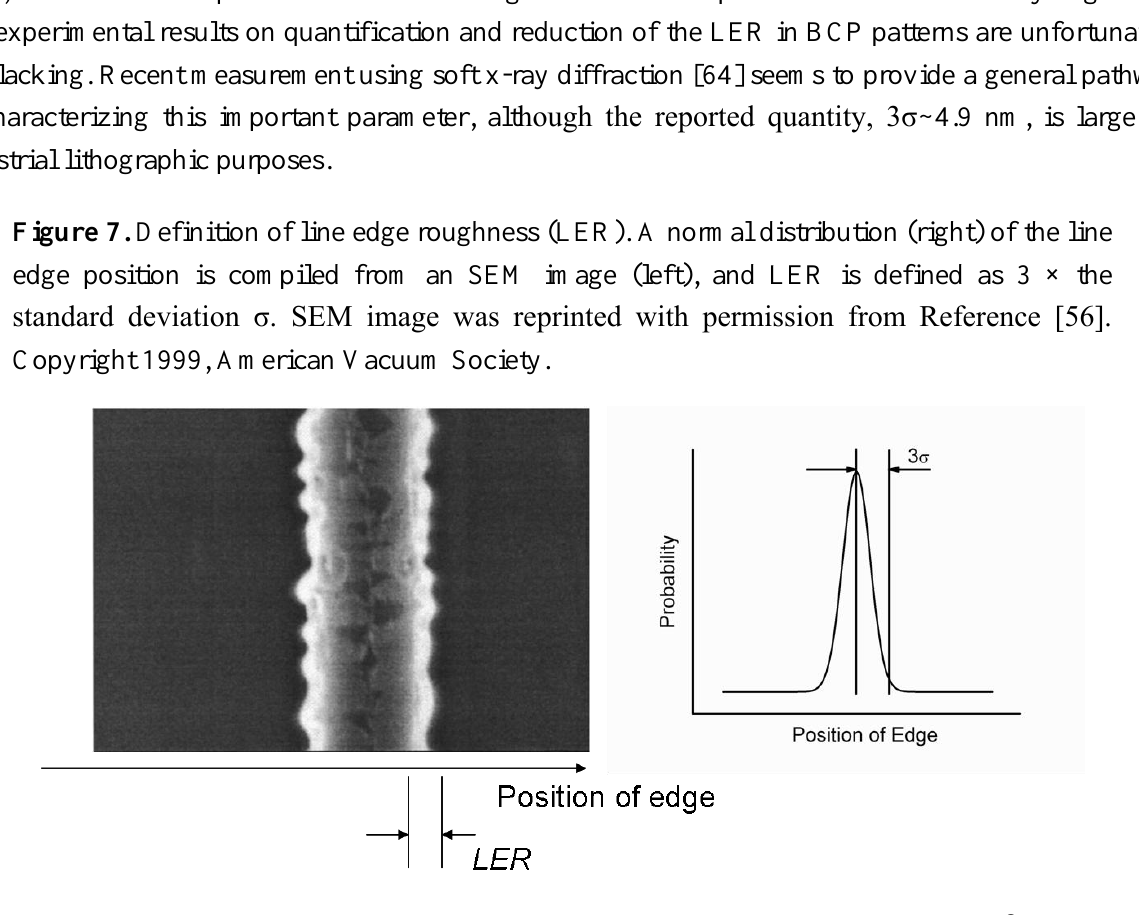
Figure 8. Illustration of ξ , the interface width between two polymer domains. f : volume fraction of each polymer block. Block A and B are randomly mixed inside the interface